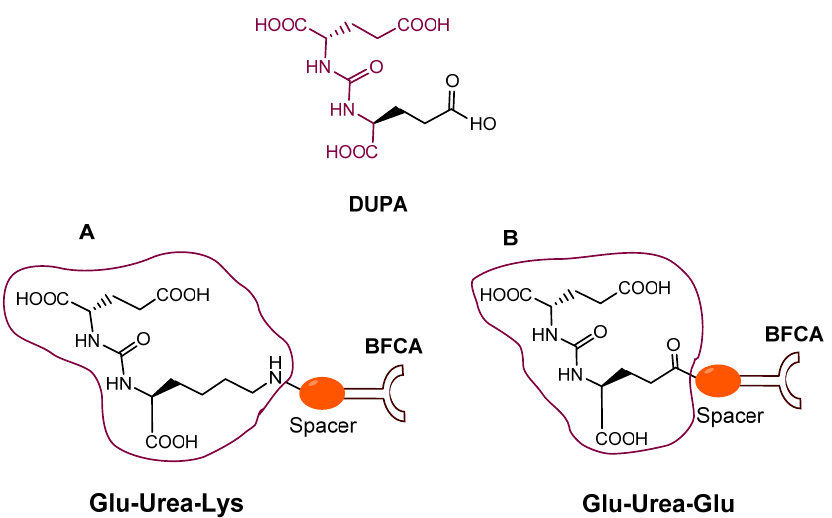
Figure 6. Chemical sketches of DUPA and PSMA-i. Glu-Ureo-based PSMA inhibitors conjugated through a spacer (in orange) to a so-called Bifunctional Chelating Agent